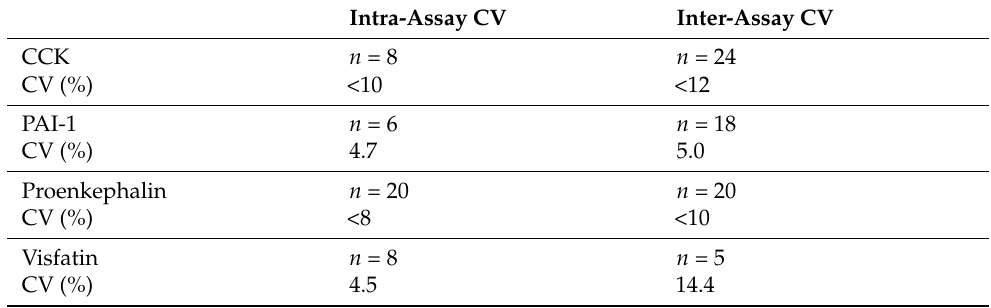
Table 3. Intra-assay and inter-assay coefficients of variance (CV) from immunological